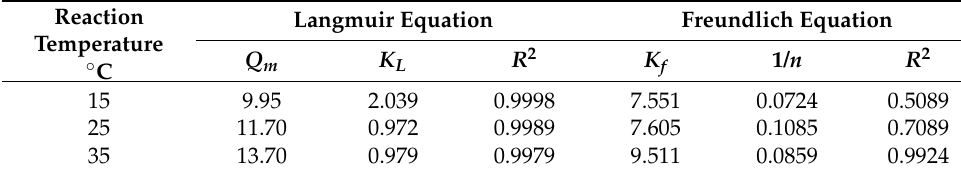
Table 2. The parameters of Langmuir equation and Freundlich equation. Reaction Langmuir Equation Freundlich Equation Temperature Q m K L R ◦ C